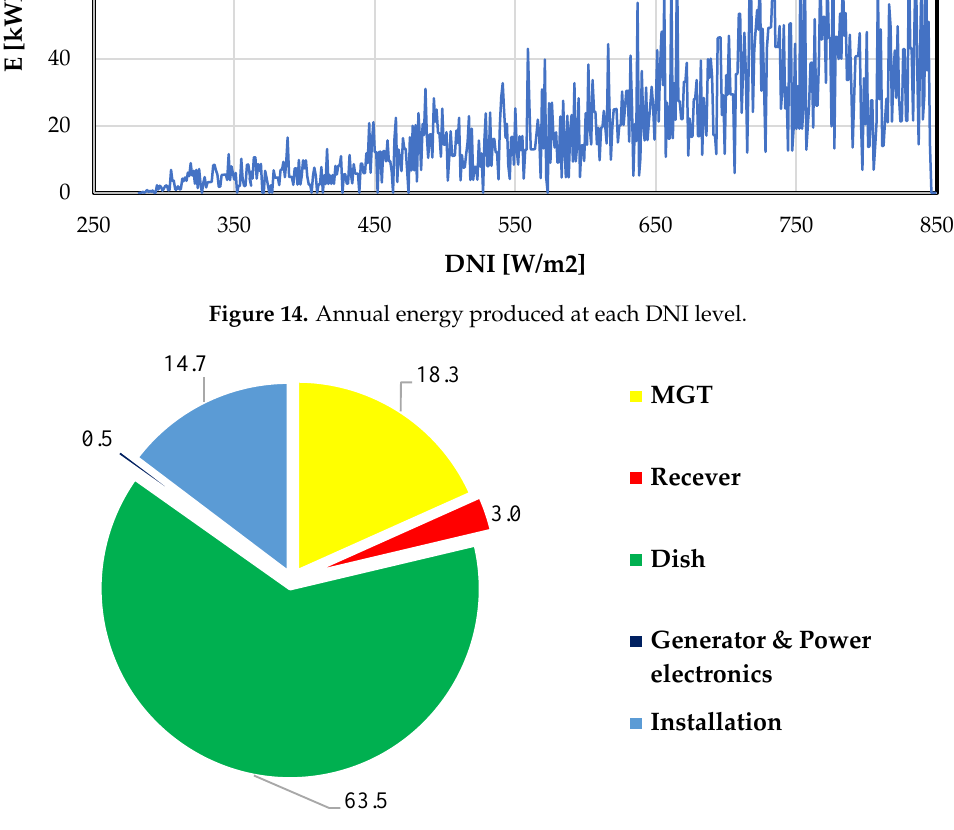
Figure 15. Cost breakdown of the plant.